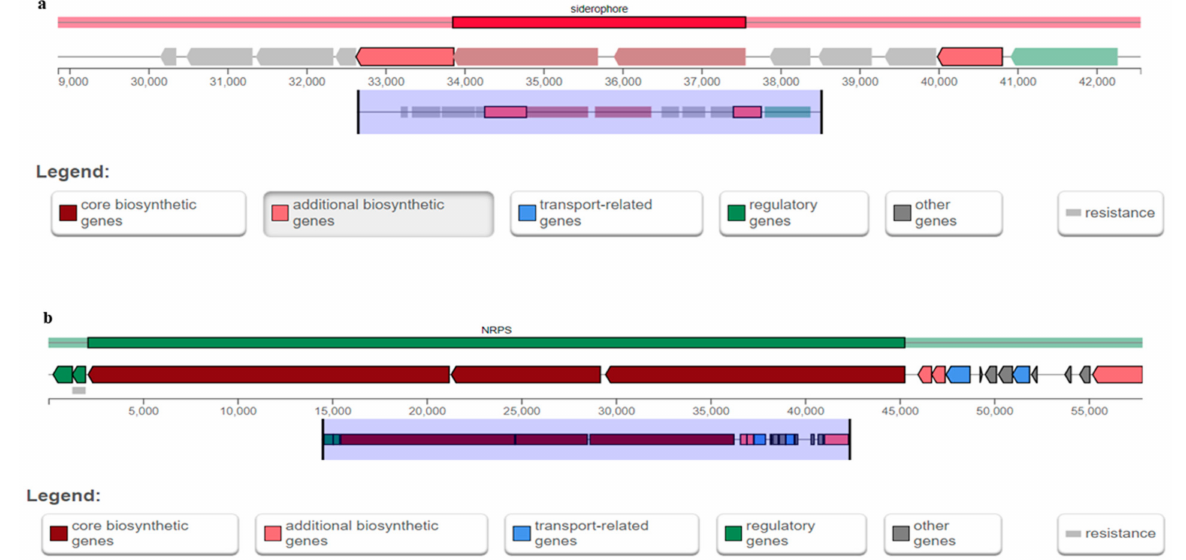
Figure 3. ( a , b ): Graphical representation of siderophore-and-nonribosomal peptide (NRPS)-encoding genes. These loci are predicted from the whole genome assembly of B. cereus